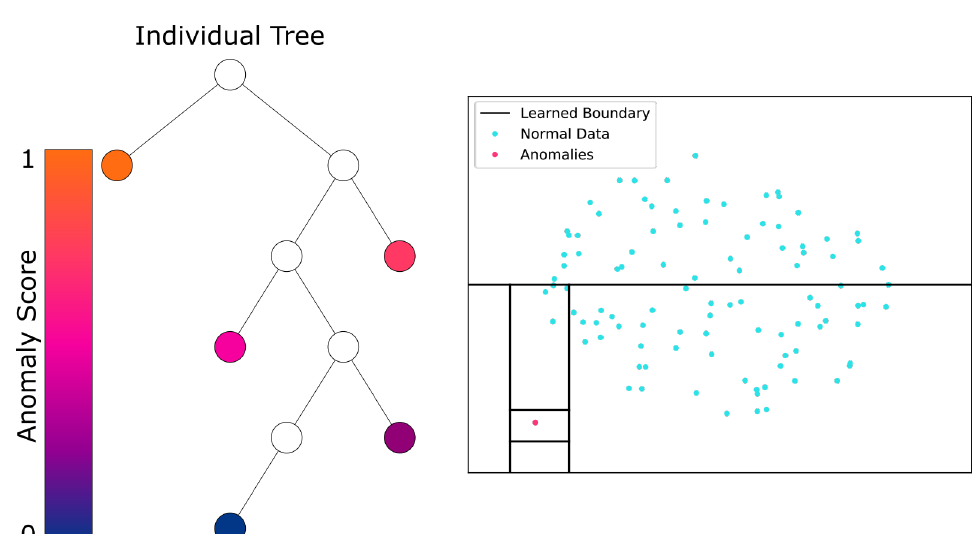
Figure 2. Example of Isolation Forest. Left : A simplified version of an individual isolation tree. Right : Example of an isolated outlier based on learned boundary.